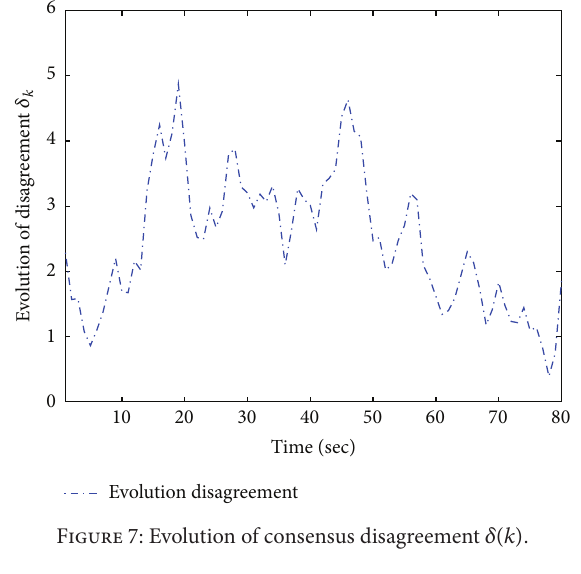
Figure 7: Evolution of consensus disagreement 𝛿(𝑘)